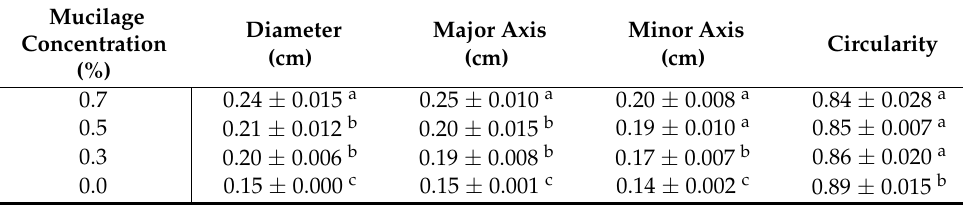
Table 3. Shape factors for each sample with different content of mucilage and alginate. Mucilage